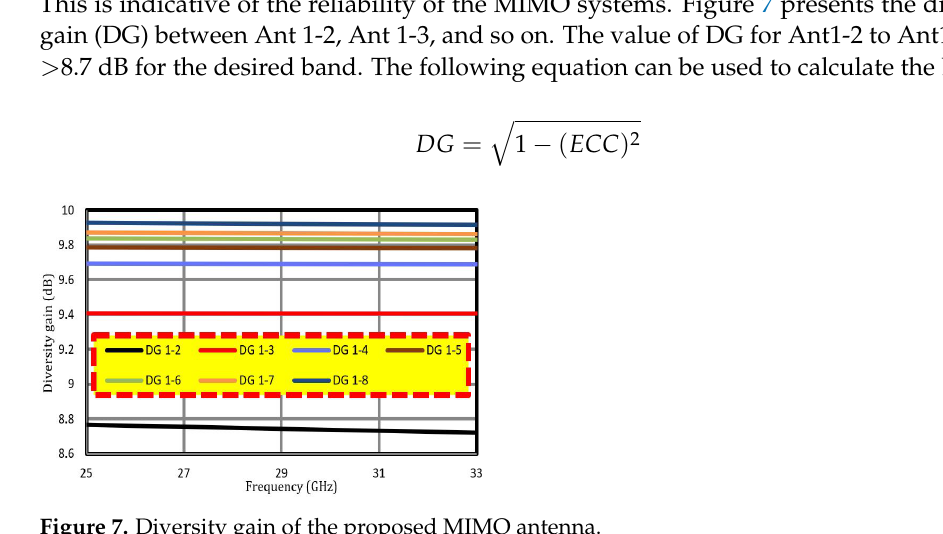
Figure 7. Diversity gain of the proposed MIMO antenna.